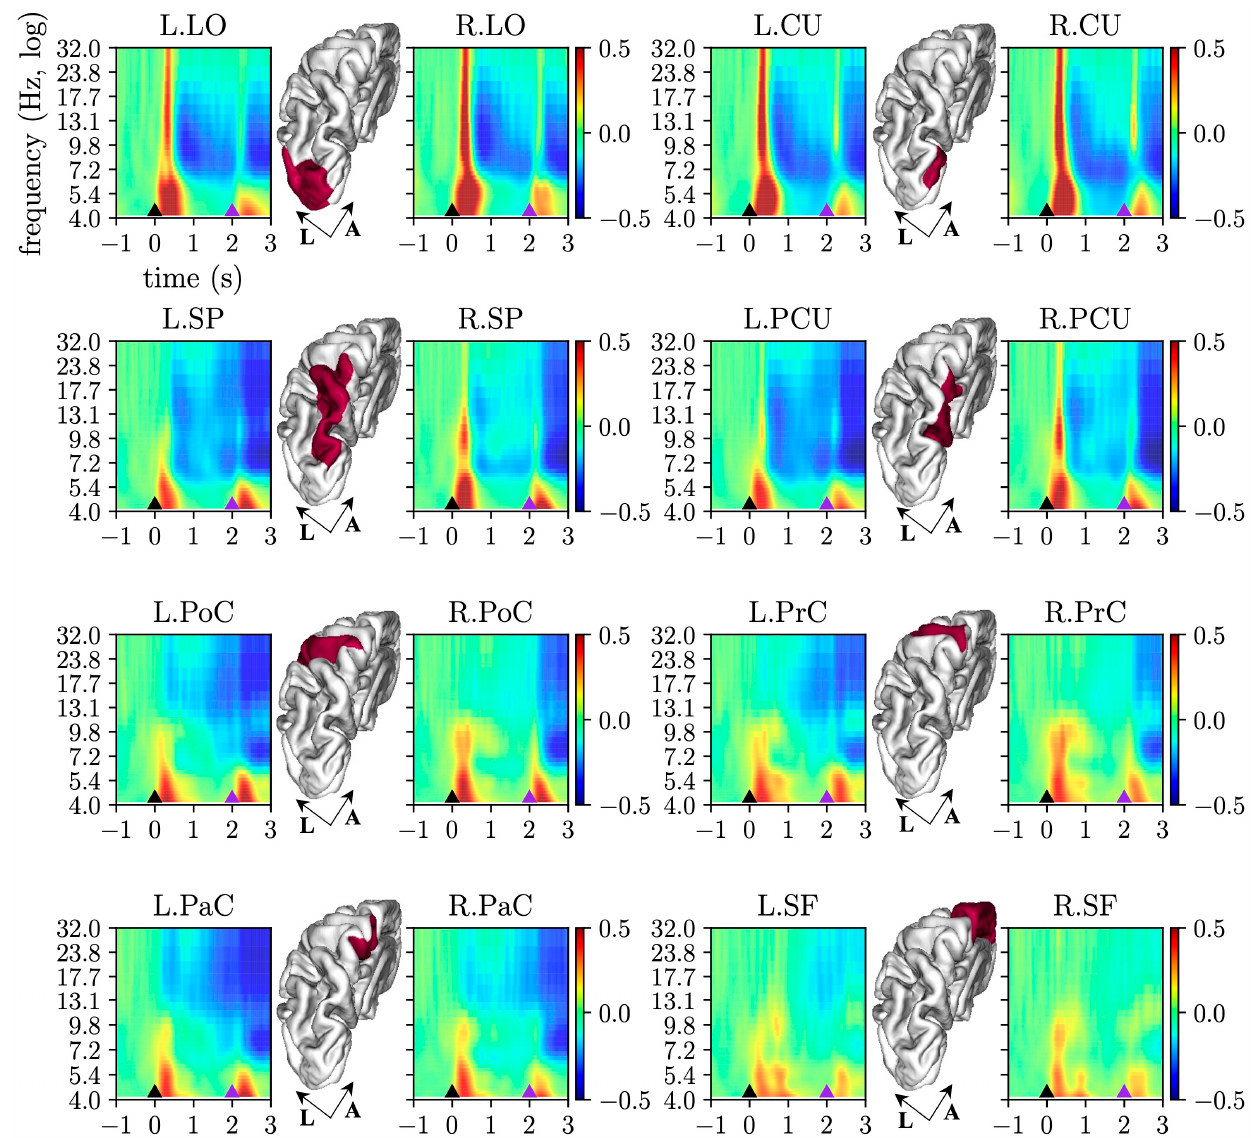
Figure 2. Event-related spectral perturbations (ERSPs). The grand-average ERSP is reported for each selected ROI of the left (label prefix “L.”) and right (label prefix “R.”) hemisphere. The small black and purple triangles at the bo tt om of each plot mark the time associated with the cue onset and go onset of the center-out reaching movement, respectively. To increase readability, x- and y-labels are reported only for the fi rst plot. The position of each ROI is also visualized, limited to the left hemi- sphere, highlighted in red in the 3-D view of the cortex (A: anterior, L: lateral).